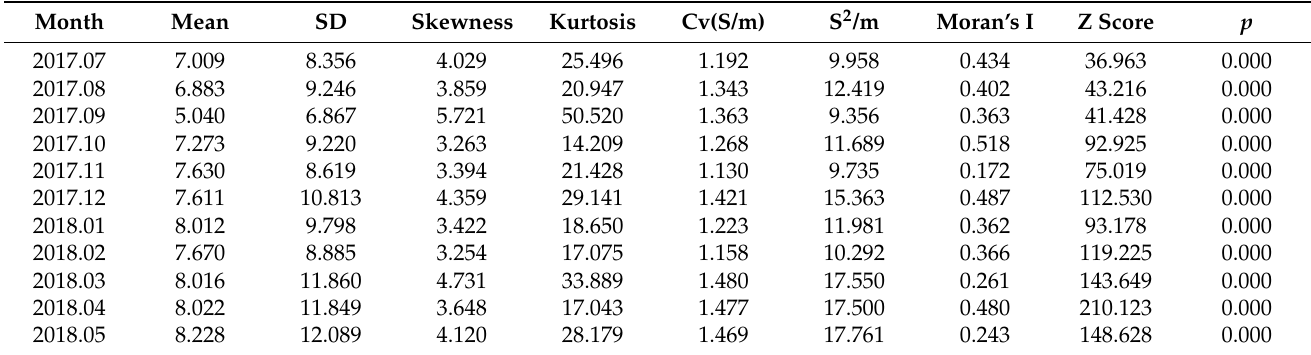
Table 1. Parameter statistics of the effort invested in high-speed transiting.